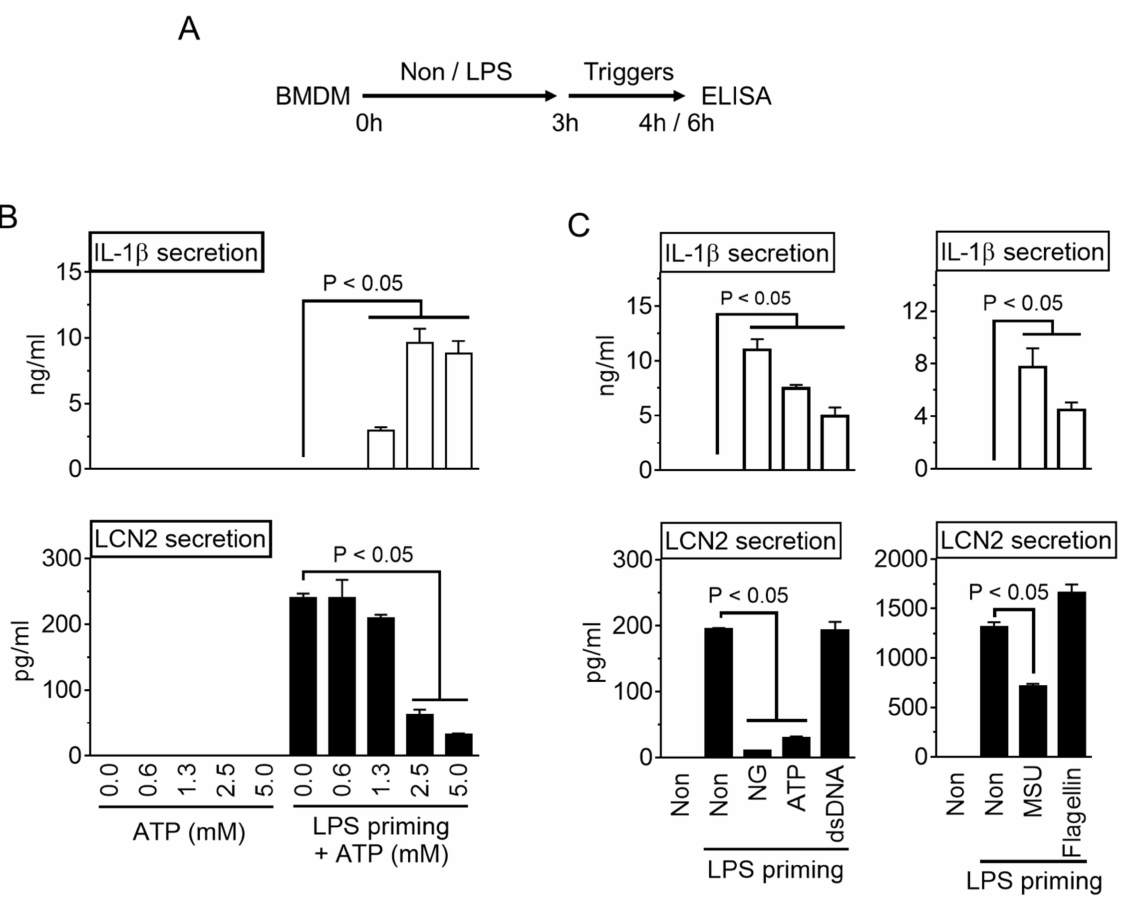
Figure 1. Effect of inflammasome activation on LCN2 secretion. ( A ) Schematic diagram of the experimental process. BMDM were primed with LPS for 3 h, and treated with a specific inflammasome trigger for 1 h or 3 h. The cellular supernatant was subjected to ELISA to measure the LCN2 or IL-1 β levels. ( B ) BMDM were primed with/without LPS for 3 h, and then treated with increasing dosages of ATP for 1 h. The secretion of IL-1 β and LCN2 were measured by ELISA. ( C ) LPS-primed BMDM were treated with the triggers of NLRP3 (NG, ATP, and MSU), AIM2 (dsDNA), or NLRC4 (flagellin) inflammasome. The IL-1 β and LCN2 secretion were observed by ELISA. The bar graph presents the mean ± standard deviation (SD) with at least two independent